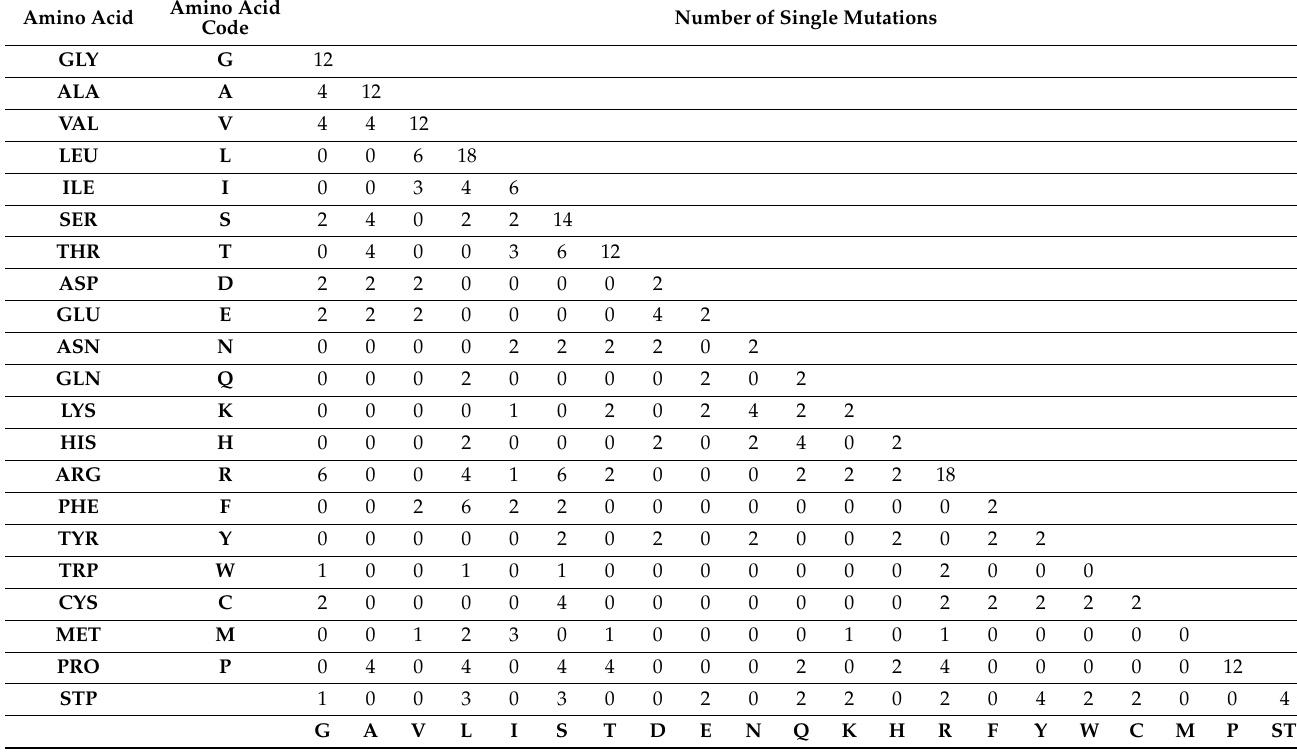
Legend: membrane and non-membrane: correlations calculated for all membrane proteins and all non-membrane proteins, respectively; All 20 and Top 11: correlations calculated for all 20 AAs and for the top 11 AAs in the ranking of [4], respectively. Table 2. Number of single mutations that result in each AA